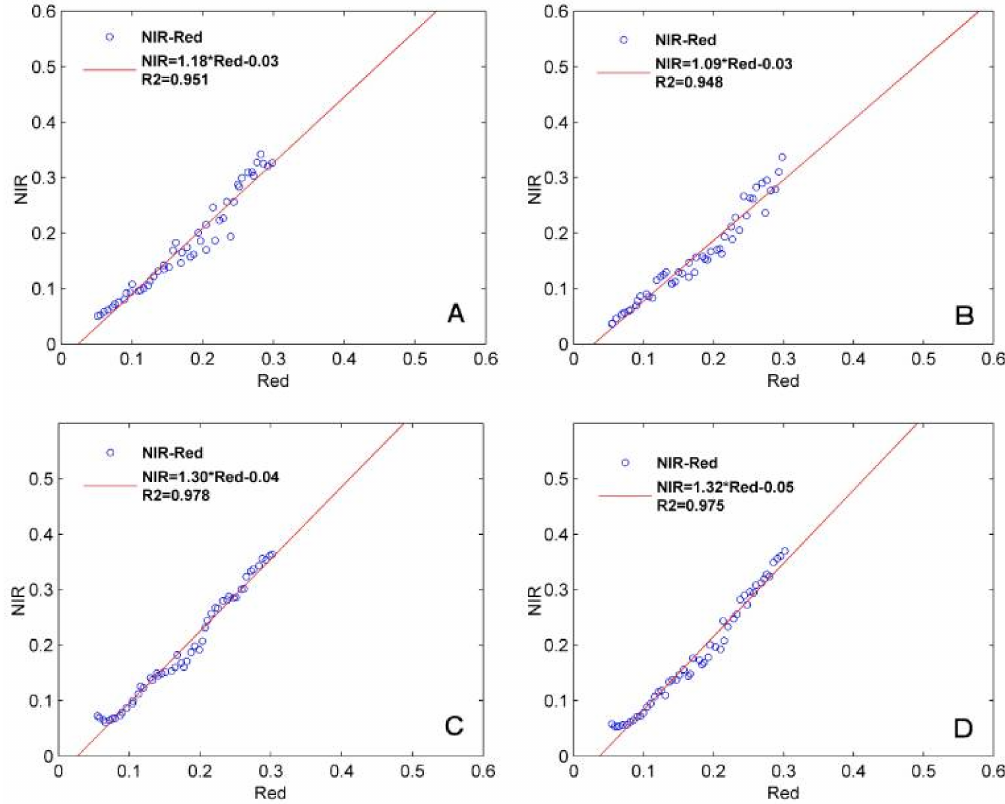
Figure 2. Fitting of soil lines in two types and two dates, ( A ) CI class in 9 August 2013; ( B ) CII class in